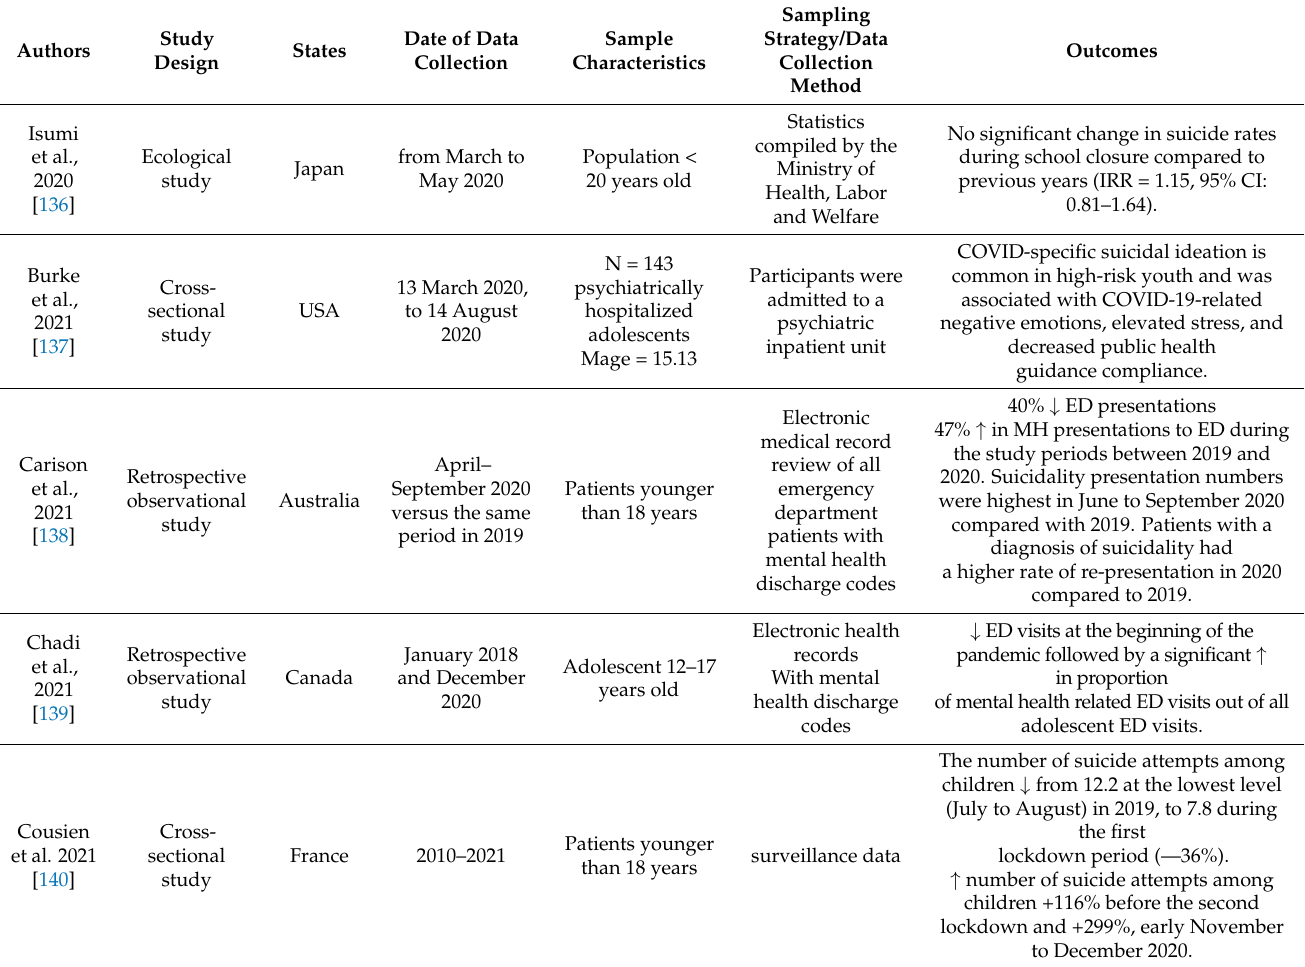
Table 3. Suicide-related issues in the youth during the COVID-19